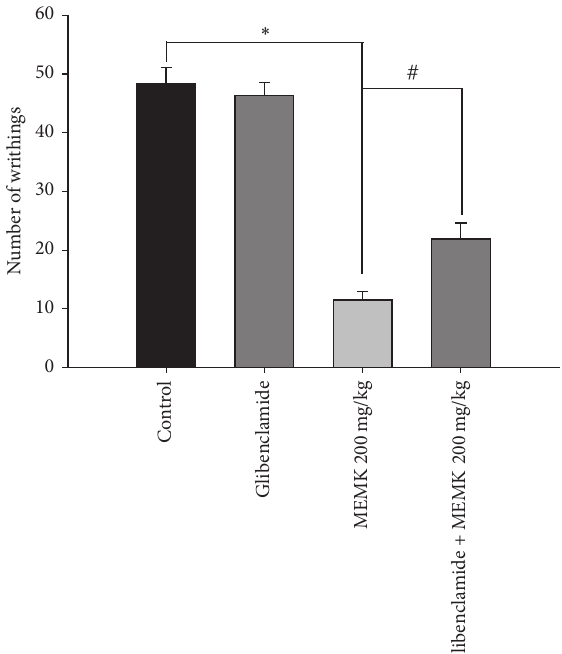
Figure 4: Reversal effects of glibenclamide in MEMK-mediated antinociception. Each group represents the mean ± SEM ( 𝑛 = 5–7). Statistical analysis was performed using one-way ANOVA followed by Dunnett’s post hoc test. ∗ 𝑝 < 0.01 compared to control and # 𝑝 < 0.05 compared to MEMK 200